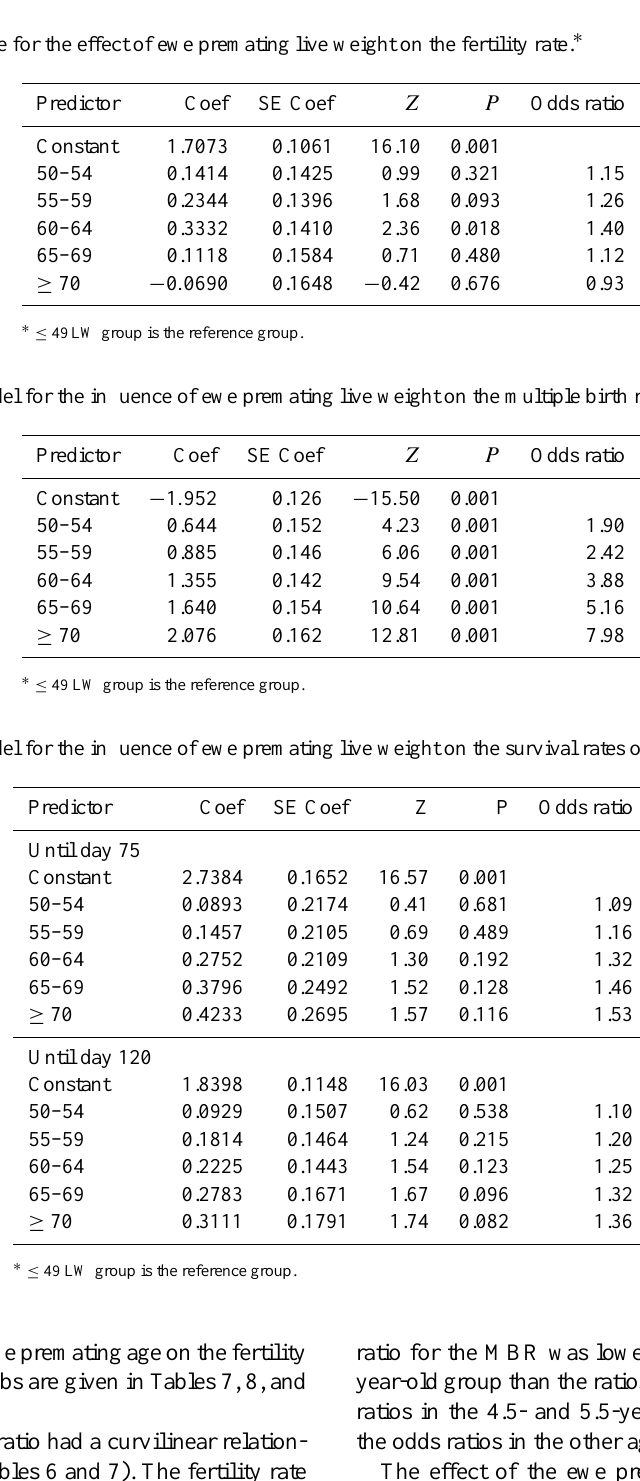
Table 3. Logistic regression table for the effect of ewe premating live weight on the fertility rate. ∗